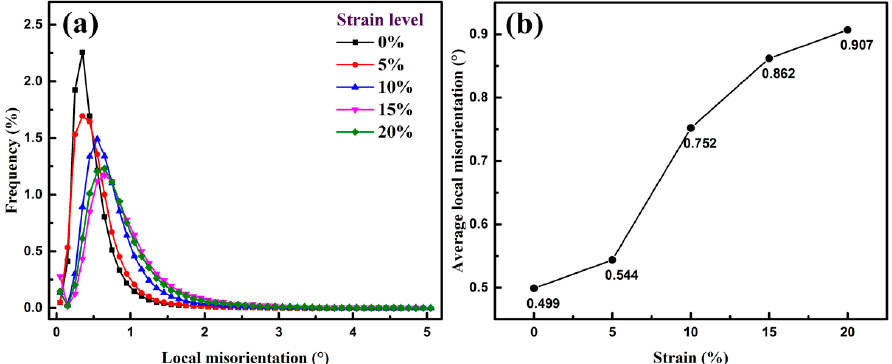
Figure 10. Change of ( a ) local misorientations and ( b ) average local misorientations of BCC phase at different strain levels. different strain